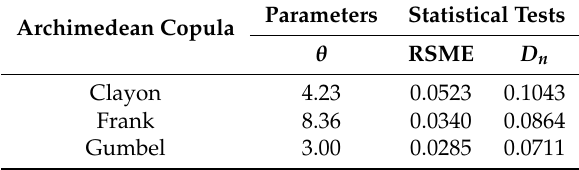
Table 6. Estimated parameters and statistical test results of the joint